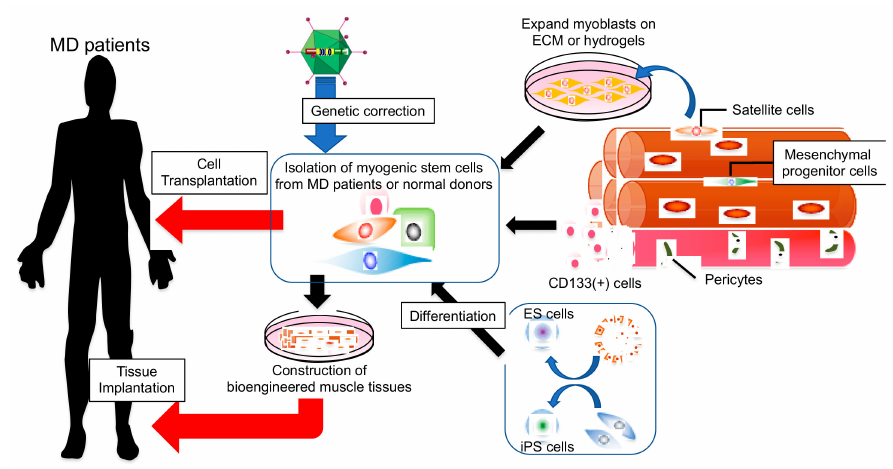
Figure 1. Therapeutic models for treatment of muscle diseases using myogenic stem cells. Muscle satellite cells, pluripotent stem cells (mesoangioblasts, and CD133 + cells) and ES / iPS cell-derived myogenic stem cells are possible cell sources for MD transplantation therapy. To generate a high yield of stem cells with myogenic potential, isolated cells are expanded by culture with ECM components or using hydrogel biomaterials. For allogeneic transplantation, isolated myogenic stem cells from MD patients are subjected to genetic correction. In addition to typical cell transplantation therapy, the implantation of bioengineered skeletal muscle tissues produced by myogenic stem cells is a promising